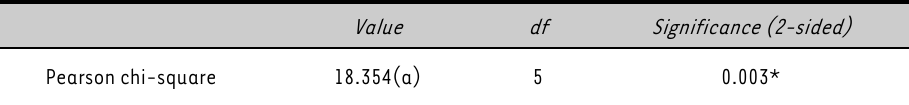
TABLE 1: Chi-square tests on applying for finance and collateral Value df Pearson